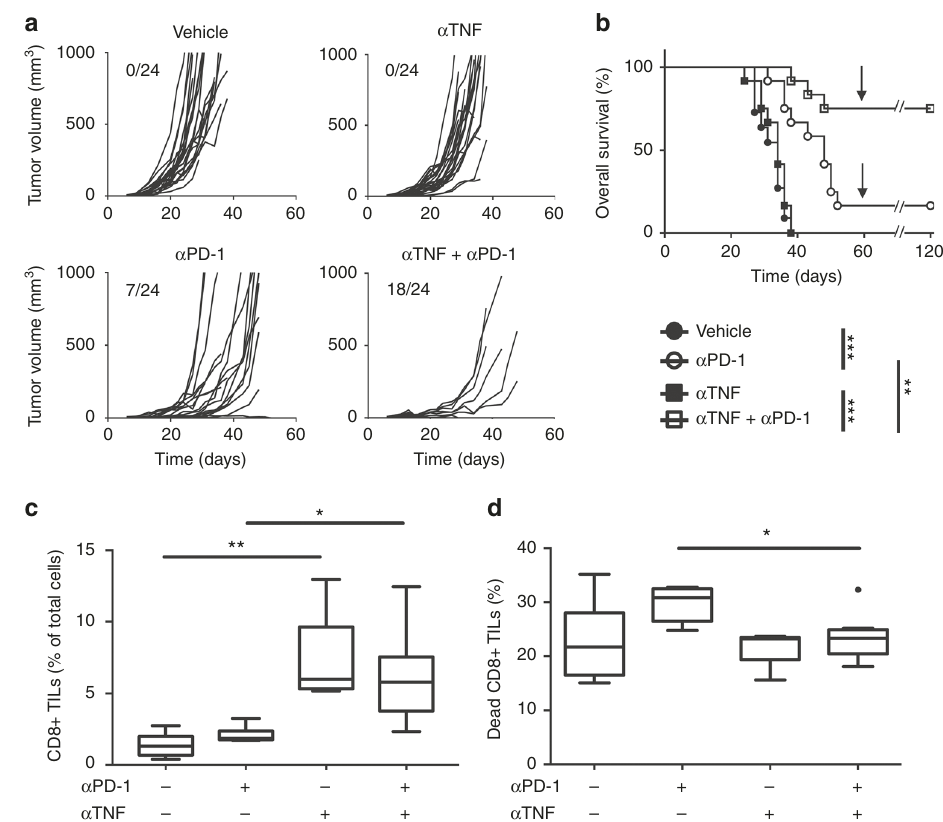
Fig. 5 Anti-TNF treatment enhances anti-PD-1 response in a mouse melanoma model. C57BL/6 wild-type (WT) mice were intradermally grafted with 3 × 10 5 B16K1 melanoma cells followed by intraperitoneal injection of anti-TNF antibodies ( α TNF, 10 mg kg − 1 ) or vehicle (PBS) at days 6, 9, 13 and 16 and/or anti-PD-1 (10 mg kg − 1 ) at days 6, 9 and 13 ( n = 12 mice per group). Data are from two independent experiments. a Individual tumor volumes are depicted. Numbers indicate complete tumor regression out of total tumors. b Cumulative survival curves. At day 60, (arrow) surviving mice were challenged with a second B16K1 injection; these mice did not develop tumors and survived (Logrank test: ** p < 0.01; *** p < 0.001). c and d C57BL/6 WT mice were intradermally and bilaterally grafted with 1 × 10 6 B16K1 melanoma cells prior to intraperitoneal injection of anti-TNF ( α TNF, 10 mg kg − 1 ) or vehicle at days 5 and 7, and with anti-PD-1 antibodies ( α PD-1, 10 mg kg − 1 ) or vehicle (PBS) at day 7. At day 10, CD8+ TILs ( c ) and the proportion of cell death in CD8+ TILs ( d ) were analysed by fl ow cytometry. Data from at least 5 tumors per group are represented as Tukey boxes (Mann – Whitney U test: * p < 0.05; ** p <